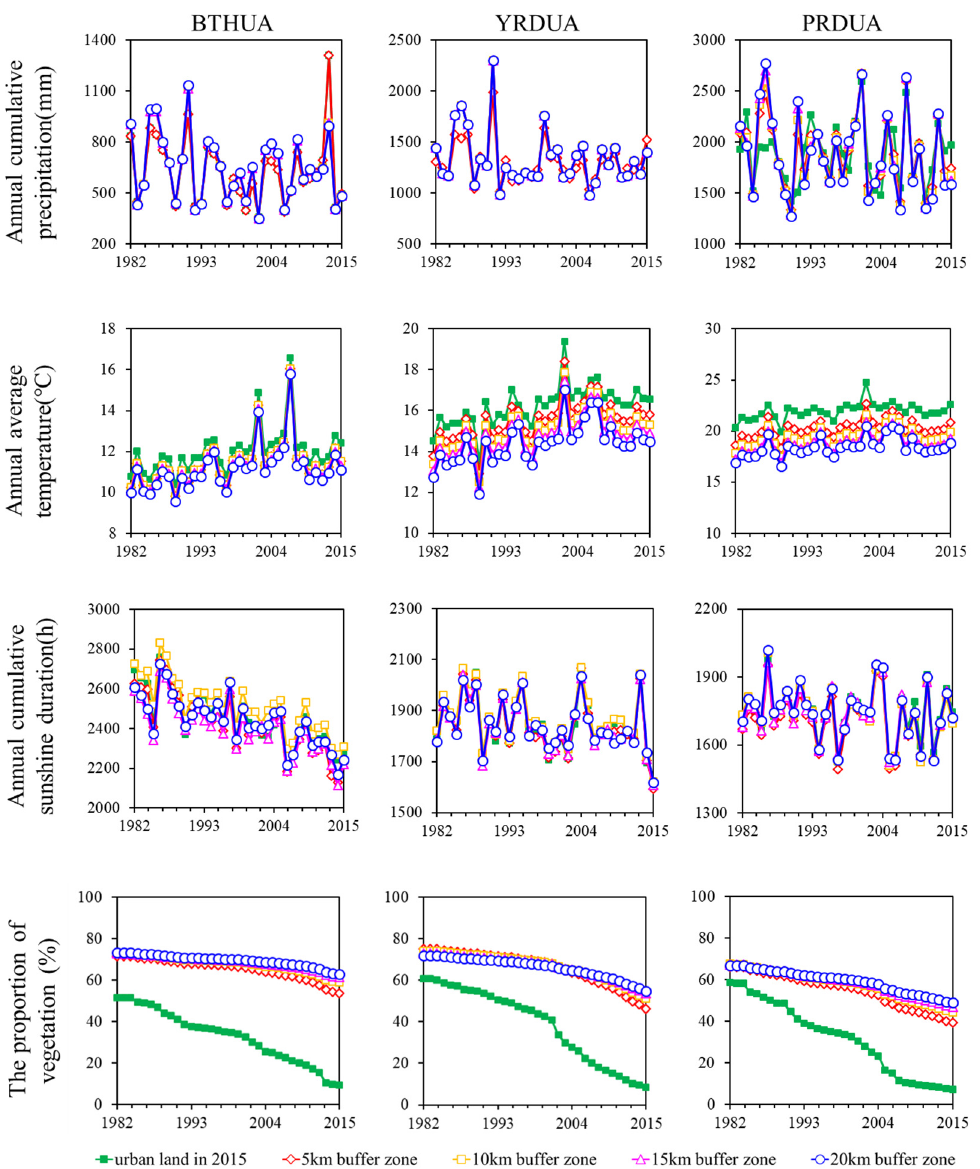
Figure 10. The annual cumulative precipitation, the annual average air temperature, the annual cumulative sunshine duration, and the proportion of vegetation in the BTHUA, the YRDUA, and the PRDUA.